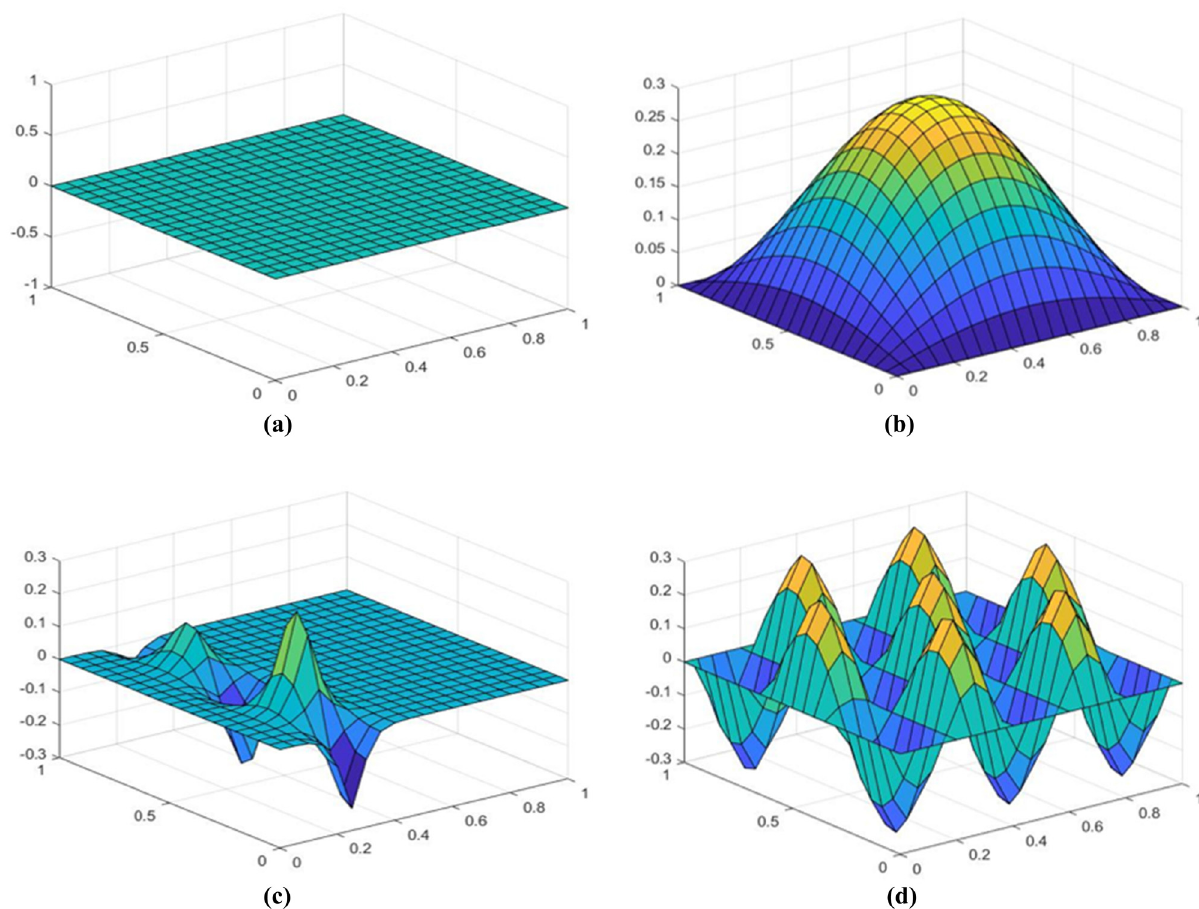
Figure 8: Di ff erent types of geometric imperfection models [ 21 ] : ( a ) Perfect plate: ( δ 1 = δ 2 = 0, ε 1 = ε 1 = 0, ψ 1 = ψ = 0 ) , ( b ) sine - type: ( δ 1 = δ 2 = 0, ε 1 = ε 2 = 1, ψ 1 = ψ = 0.5 ) , ( c ) local - type: ( δ 1 = 30, δ 2 = 3, ε 1 = 2, ε 2 = 4, ψ 1 = ψ 2 = 0.25 ) , and ( d ) global - type: ( δ 1 = 0, δ 2 = 0, ε 1 = 5, ε 2 = 3, ψ 1 = ψ = 0.25 ) . 2